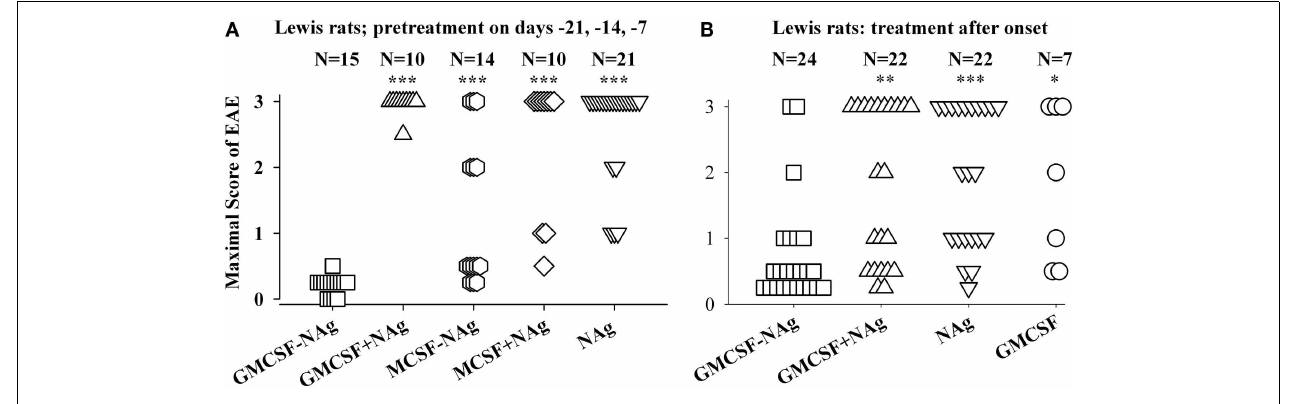
previously reported in (Blanchfield and Mannie, 2010).The clinical scoring scale for rats was; 0, no disease; 0.25, distal limp tail; 0.5, limp tail; 1.0, ataxia; 2.0, partial hind-limb paralysis; 3.0, full hind-limb paralysis. p values were calculated as described in Figure 2 .These data were previously portrayed in Tables 1 and 2 respectively of (Blanchfield and Mannie, 2010). (*** p ≤ 0.001; ** p ≤ 0.01; * p ≤ 0.05 for comparison of the respective treatment groups to that of